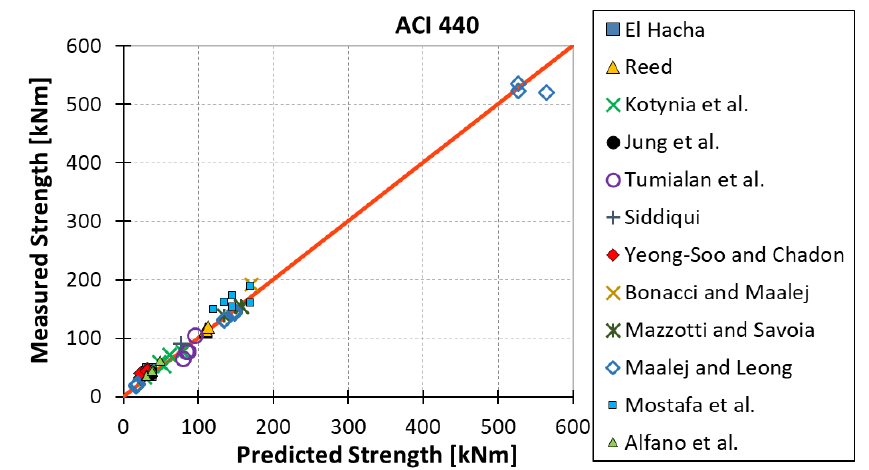
Figure 9. Measured flexural strength versus Elsanadedy et al. model prediction.